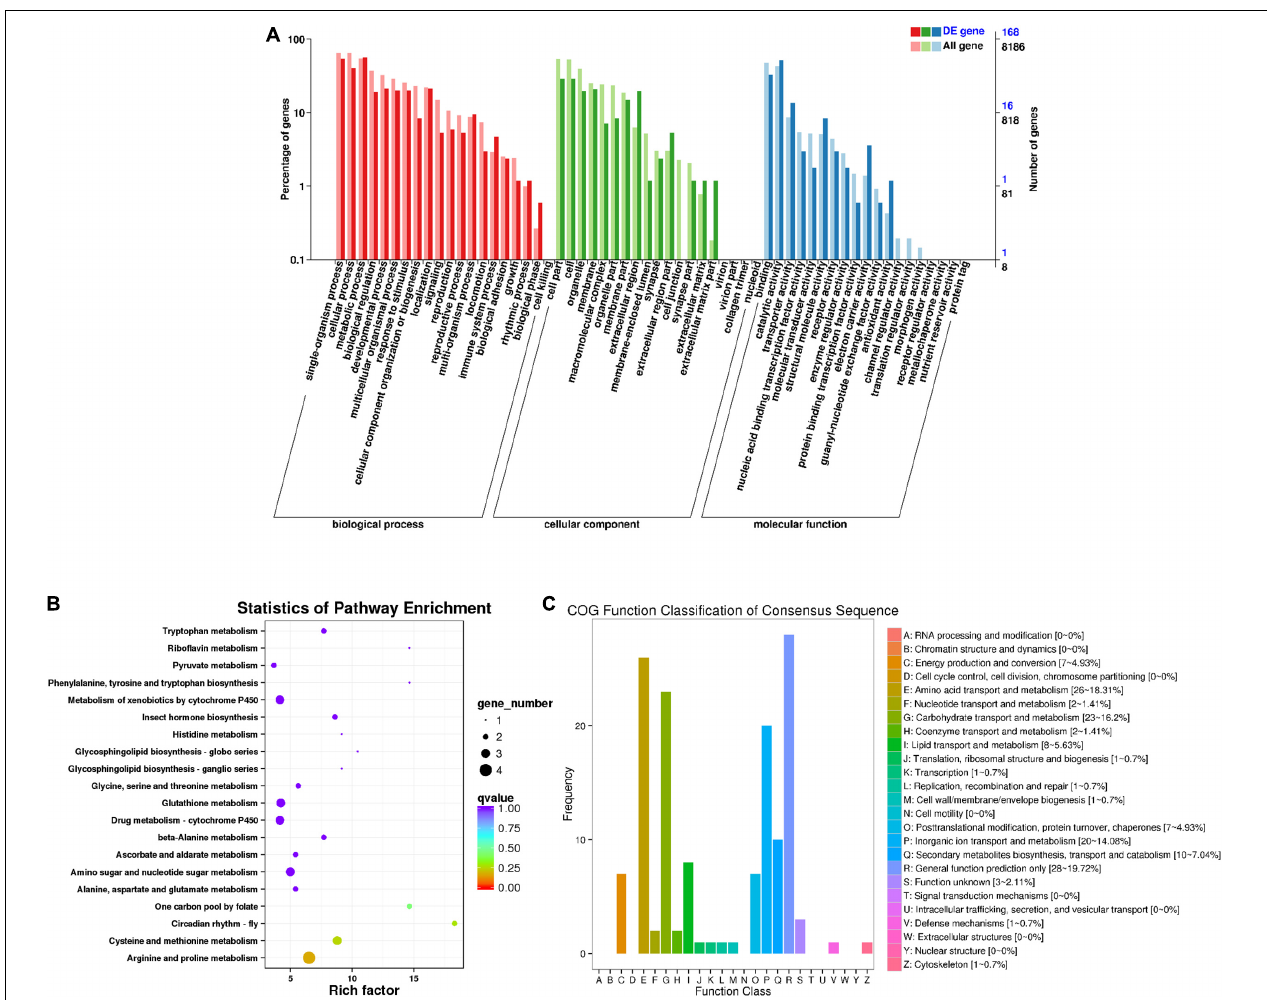
FIGURE 3 | Male differentially expressed gene analysis. (A) Annotated statistical graph of the GO secondary nodes. Light colors represent all genes and dark colors represent all differentially expressed genes (DEGs) of adult males. (B) Scatter plot of enriched KEGG pathways. Each circle in the graph represents the number of genes enriched for a specific KEGG pathway. Enrichment factors represent the ratio of the number of differentially expressed genes to all the genes in the pathway. (C) COG annotation classification statistics of differentially expressed genes in males. Frequency is the number of